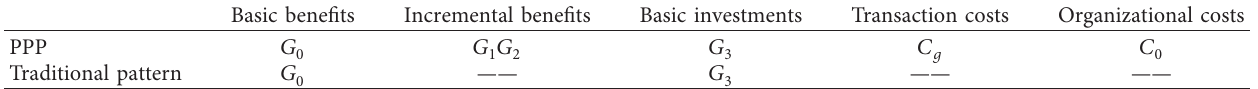
Table 3: Benefit parameters and cost parameters for the government under two patterns.